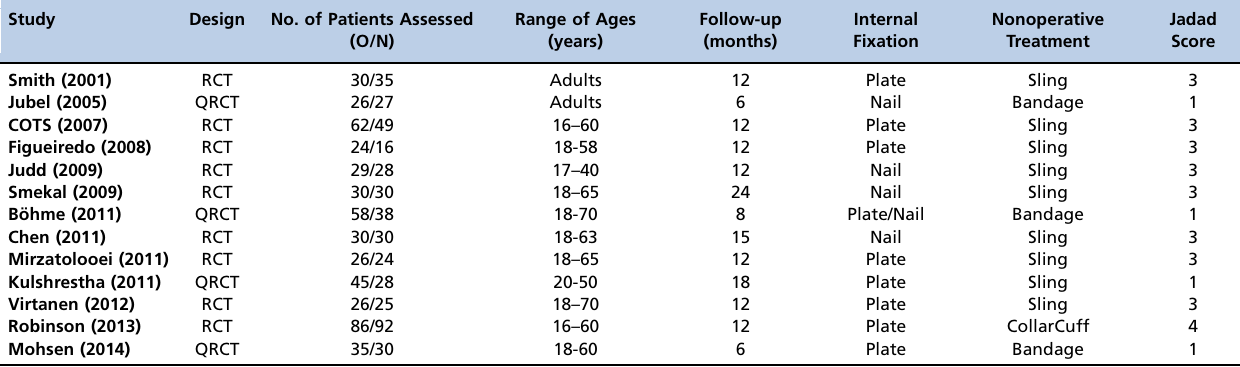
Table 1 - Characteristics and methodological quality of the included